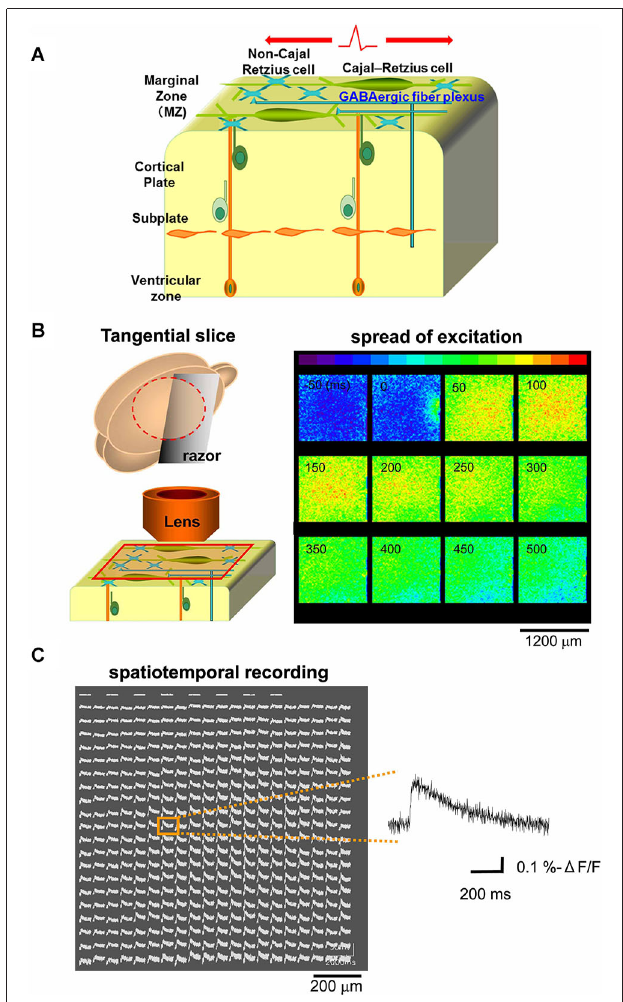
FIGURE 1 | Optical voltage recording in tangential neocortical slices . (A) Schematic diagram showing cellular and axonal components of the tangential direction of the MZ. (B) Left: schematic diagram showing preparation of tangential slice and optical recording from the MZ. Right: the main component of the optical signal evoked by single electrical stimulations spread out over the MZ, so that excitatory optical signals were recorded spatially (colored in red). Note that the stimulating electrode was placed on the edge of the recorded area (see panel at 0 ms). (C) Spatiotemporal recordings enable us to analyze the evoked optical signals which spread in horizontal direction within the MZ. Representative traces were chosen (inset) for analyses at distances of 800 µ m from the stimulation